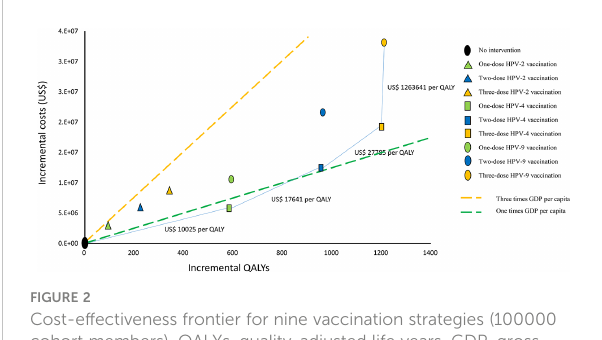
FIGURE 2 Cost-effectiveness frontier for nine vaccination strategies (100000 cohort members). QALYs, quality-adjusted life years, GDP, gross domestic product, HPV-2: HPV bivalent vaccine, HPV-4, HPV quadrivalent vaccine, HPV-9, HPV nonavalent vaccine.